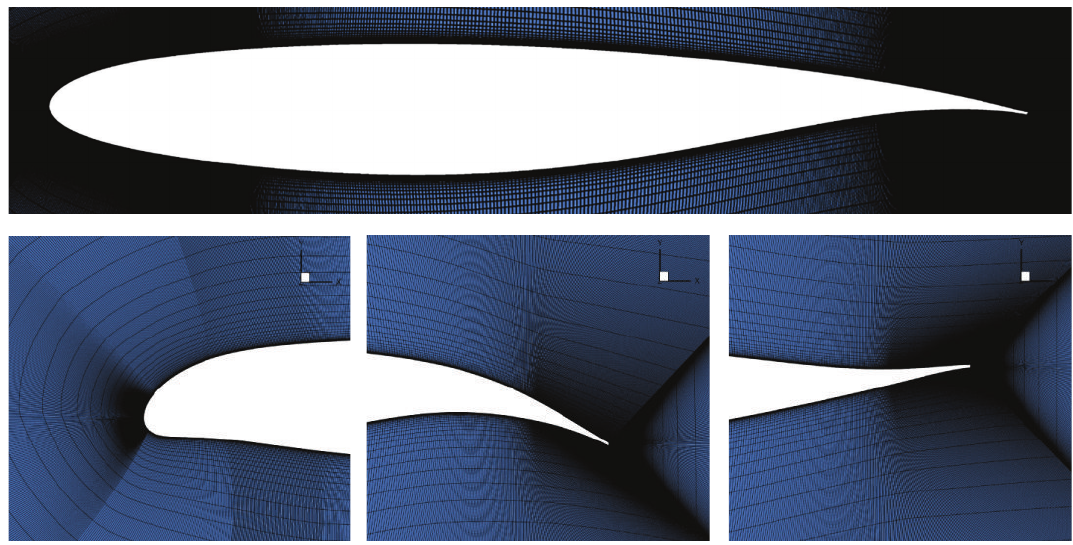
Figure 5: Parametric meshing around undeformed airfoil and corresponding morphing leading and trailing edge shapes.